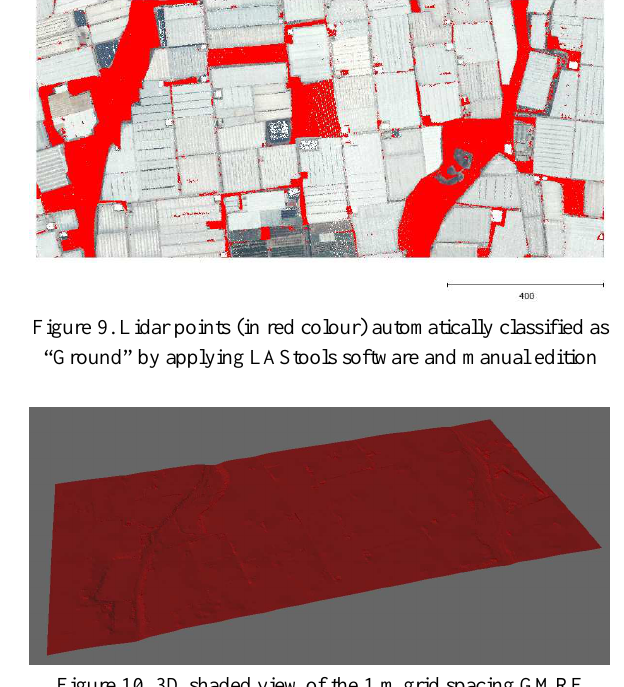
Figure 10. 3D shaded view of the 1 m grid spacing GMRF DTM computed from only LiDAR ground points. σ p = 1